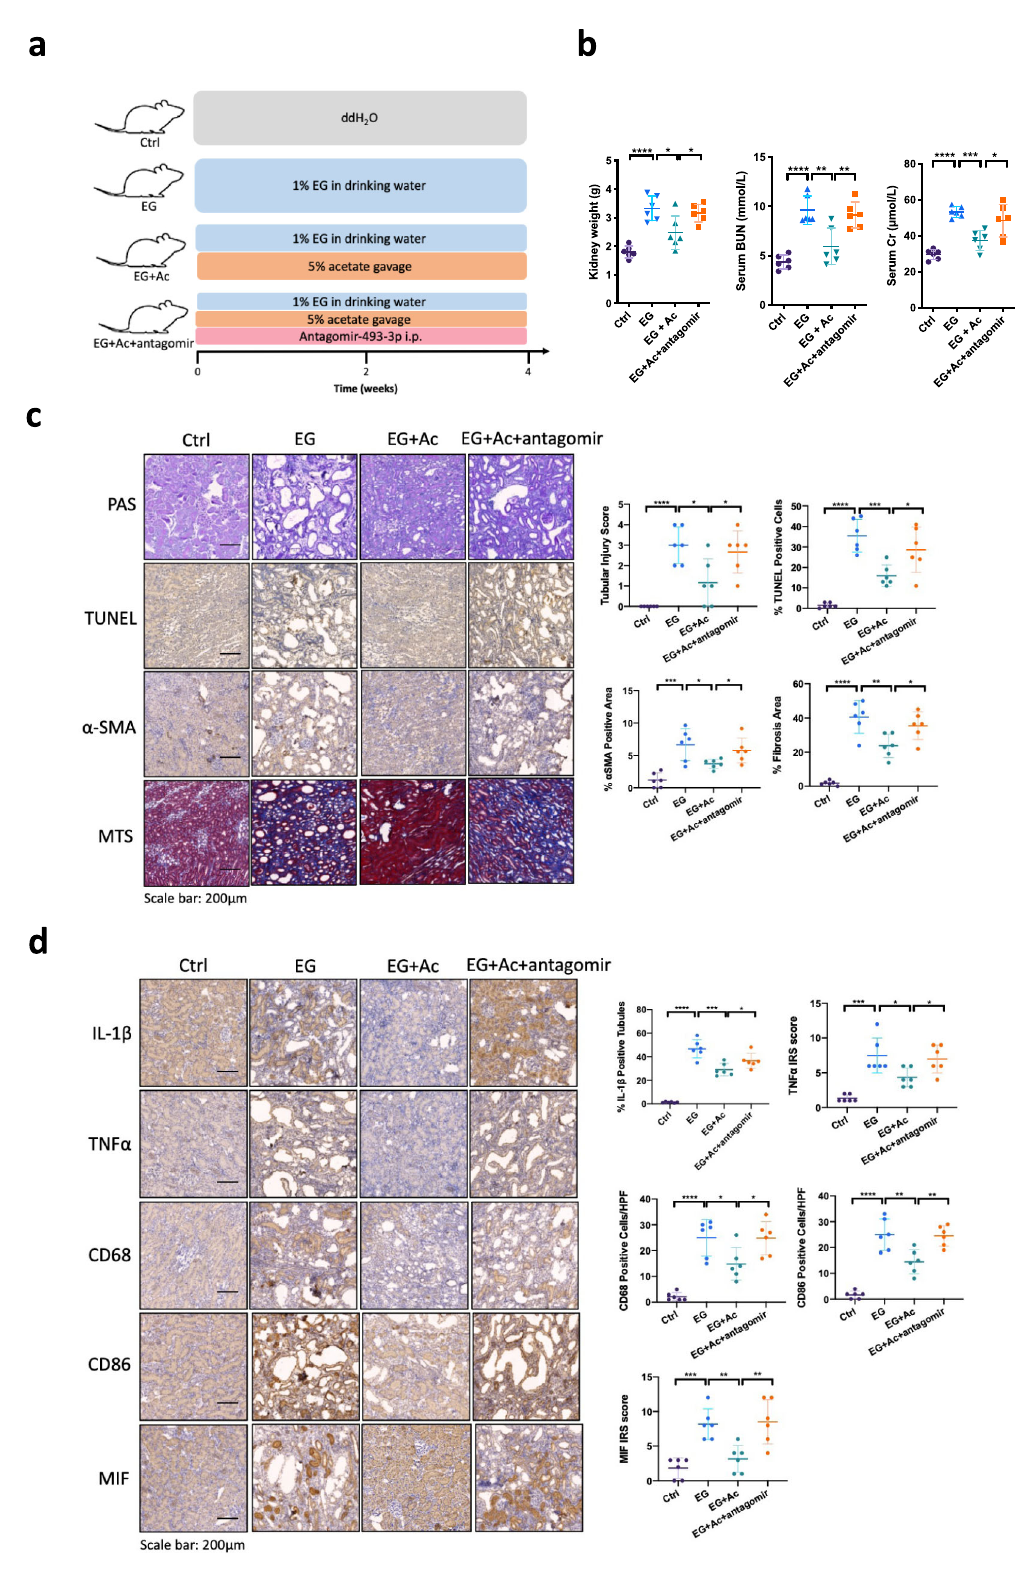
Fig. 6 Antagomir-493-3p treatment attenuated acetate effects of regulating macrophages recruitment and decreasing renal injury. a A diagram describing the injection schedule for antagomir-493-3p; EG, ethylene glycol; i.p., intraperitoneal injection. b Renal function was quanti fi ed by serum creatinine and BUN levels, and kidney weight. n = 6 for each group. c Representative histologic kidney images of PAS, TUNEL, α SMA and Masson ’ s trichrome stain (MTS). d Immunostaining of IL-1 β , TNF α , CD68, CD86, and MIF in kidney sections. n = 6 for each group. For ( c ) and ( d ), quantitations are at the right. * P < 0.05, ** P < 0.01, *** P < 0.001, **** P < 0.0001.